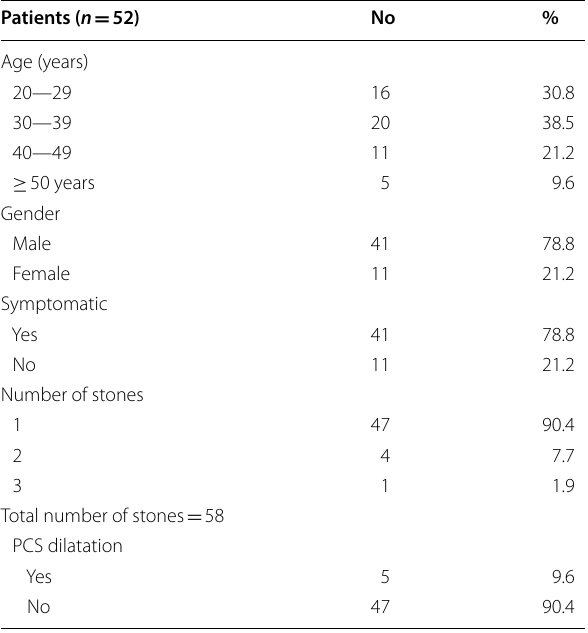
Table 1 Demographic data of patients with small